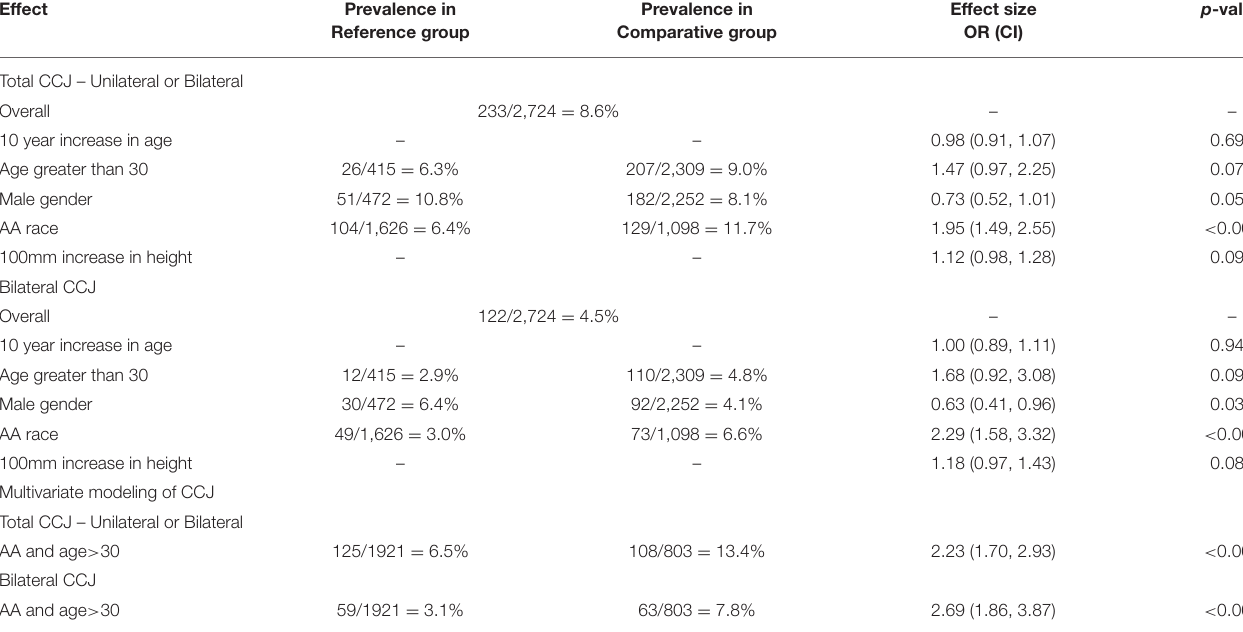
TABLE 2 | Prevalence of Coracoclavicular Joint (CCJ).